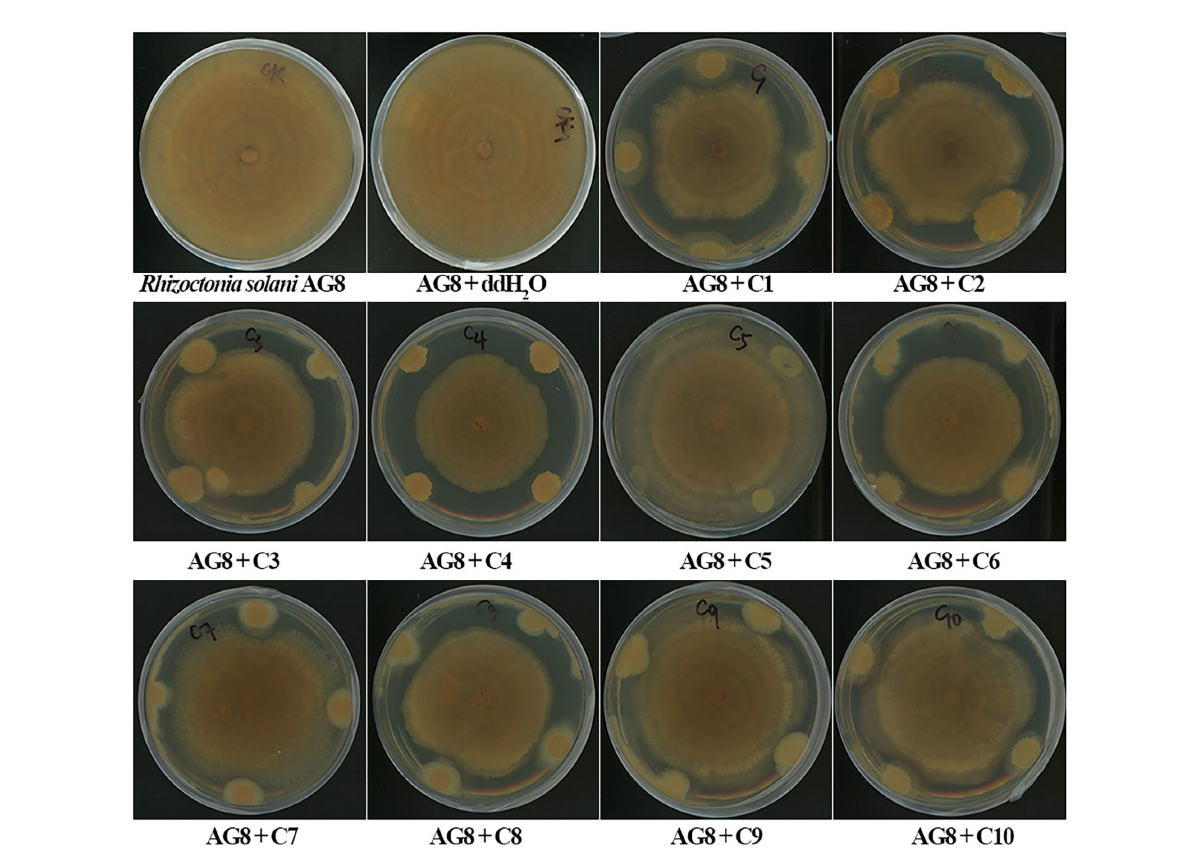
FIGURE 1 The inhibition of synthetic microbial communities (SynComs) on the growth of Rhizoctonia solani AG8 in dual-culture assay. C1: SynCom 1; C2: SynCom 2; C3: SynCom 3; C4: SynCom 4; C5: SynCom 5; C6: SynCom 6; C7: SynCom 7; C8: SynCom 8; C9: SynCom 9; C10: SynCom